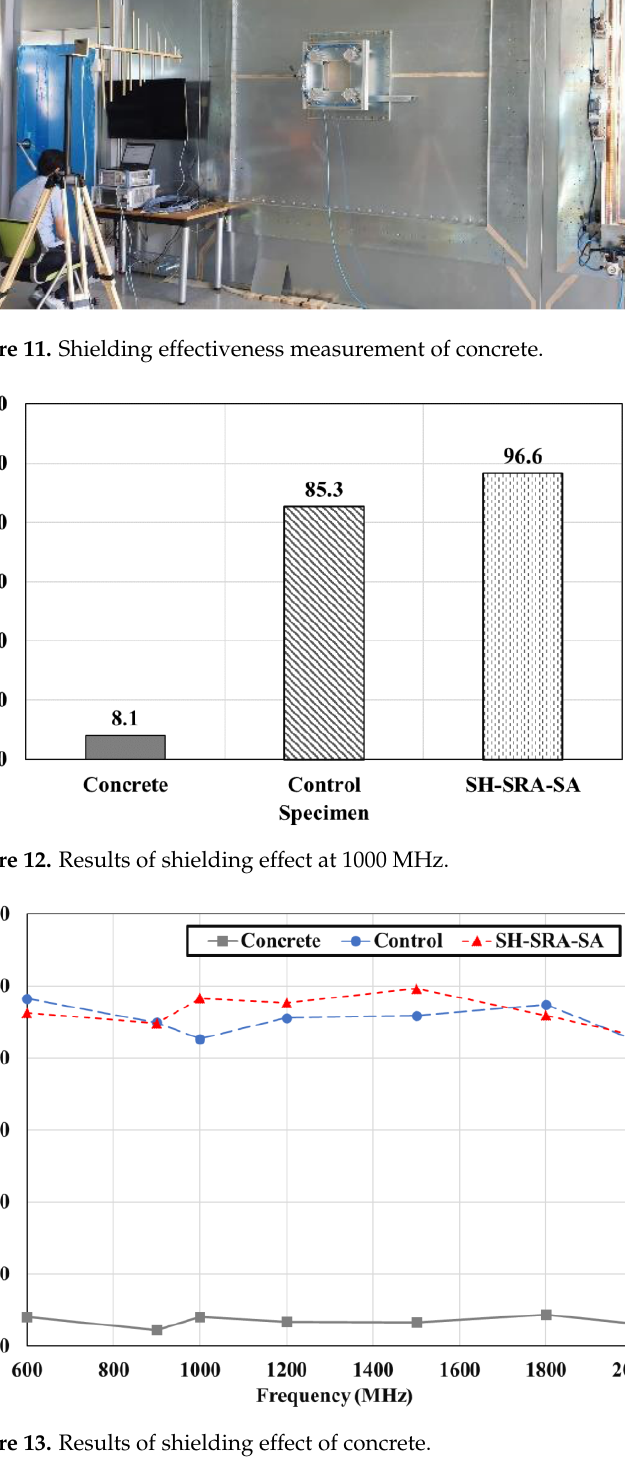
Figure 13. Results of shielding effect of concrete.